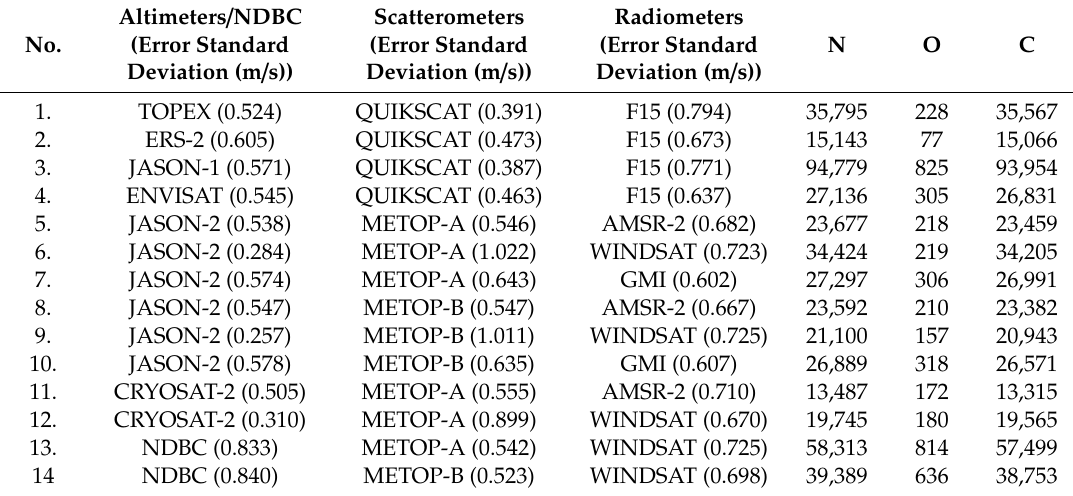
Table 1. All possible triplet-collocated datasets and their random error standard deviations shown in the parentheses. N is the number of matchups after quality assurance criteria are applied, O is the number of outliers, and C = N-O is the number of observations used to estimate the error